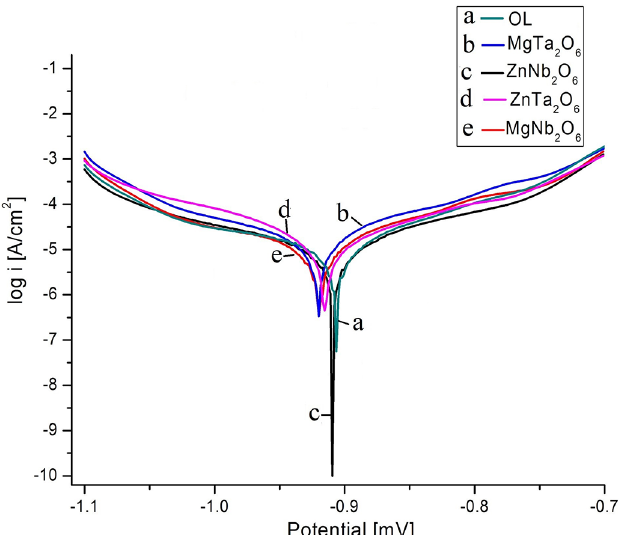
Fig. 6. Tafel representation of polarization curves recorded in 0.5M Na 2 SO 4 for the studied electrodes: (a) OL , (b)MgTa 2 O 6 , (c) ZnNb 2 O 6 , (d) ZnTa 2 O 6 and (e) MgNb 2 O 6 .